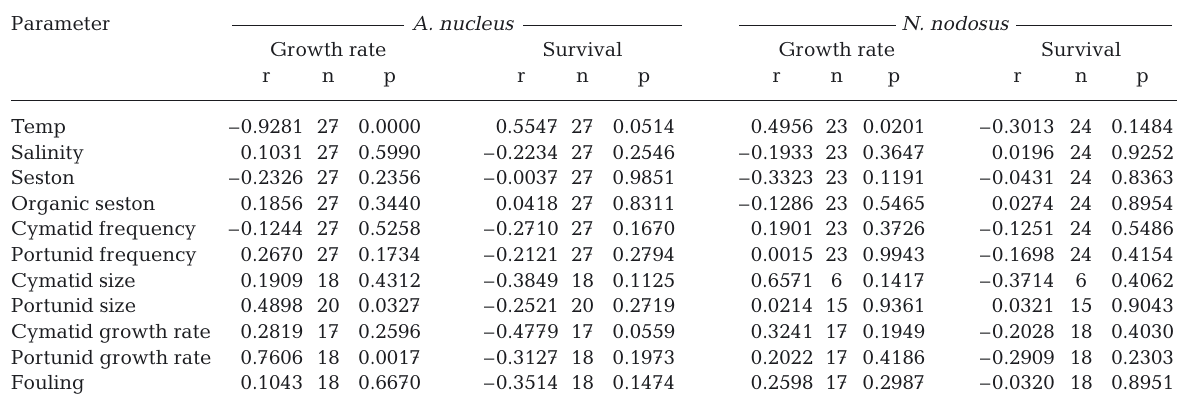
Table 3. Spearman correlation analysis between environmental parameters, the monthly growth rates and survival values of Argopecten nucleus and Nodipecten nodosus under different suspended culture conditions Parameter